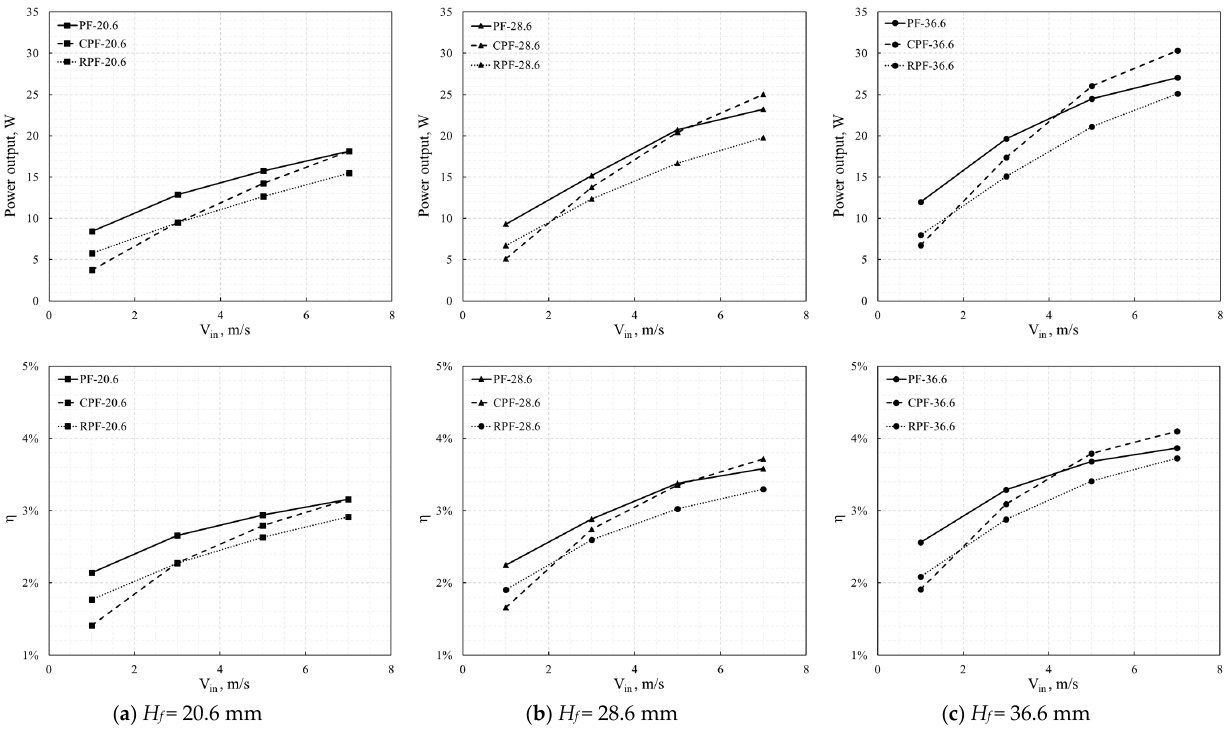
Figure 15. Maximum power output (upper) and efficiency (lower) of TEG module with different fin structures and inlet velocities of flue gas ( T in = 600 °C).